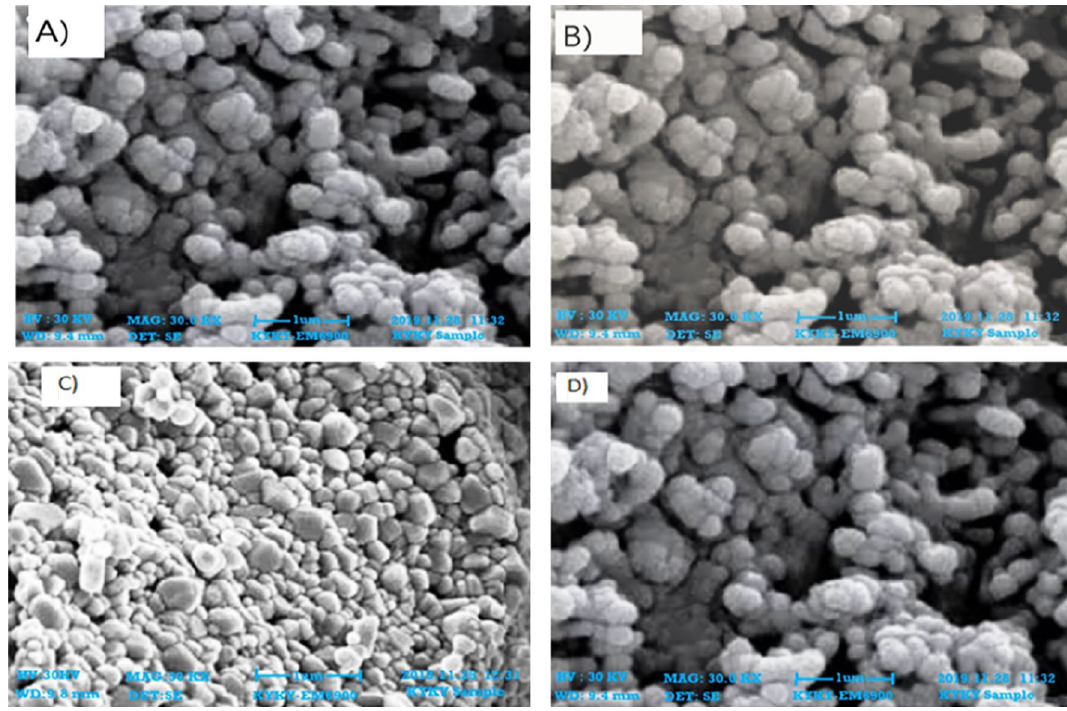
Figure 2. SEM images of zinc oxide nanoparticles. ( A ) n-Hexane ( B ) Ethyl Acetate ( C ) Methanol ( D ) Aqueous.